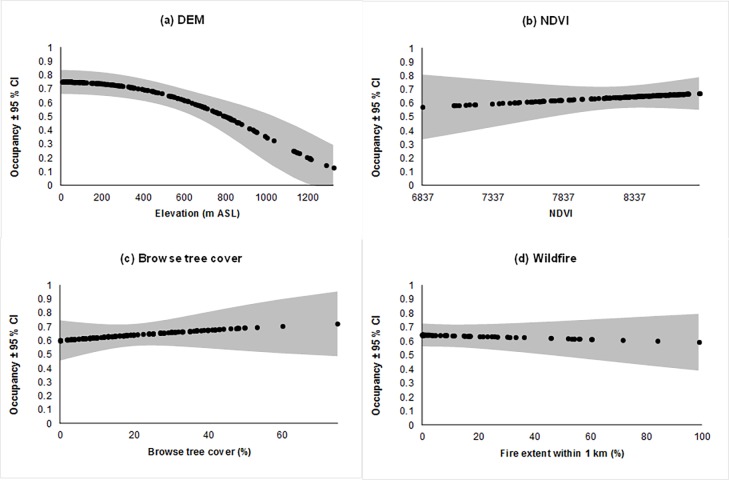
The relationship between modelled probability of occupancy for koalas and (A) elevation (quadratic), (B) NDVI (quadratic), (C) Important browse tree cover and (D) Wildfire extent in last 10 years. Other supported co-variates are held at their mean when displaying individual relationships. Grey areas indicate ±95% CLs.